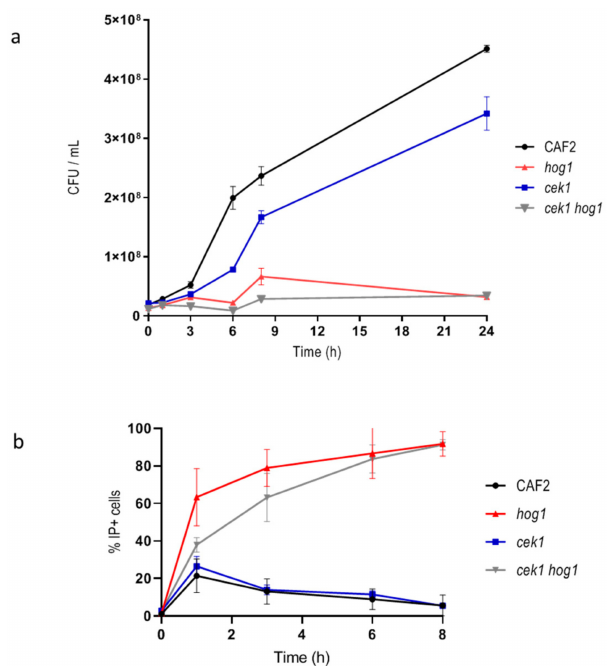
Figure 1. Quantification of cell viability upon hyperosmotic challenge. ( a ) Graph showing the cellular growth by CFUs / mL count along the time of the indicated strains. ( b ) Graph represents IP + cells quantified by flow cytometry along the time. Graphs show the mean and the standard error of the mean of at least three independent